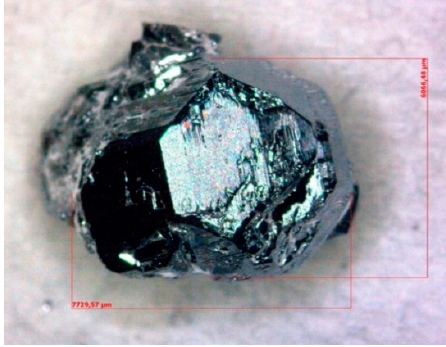
Figure 2. The morphological image of the largest crystal.